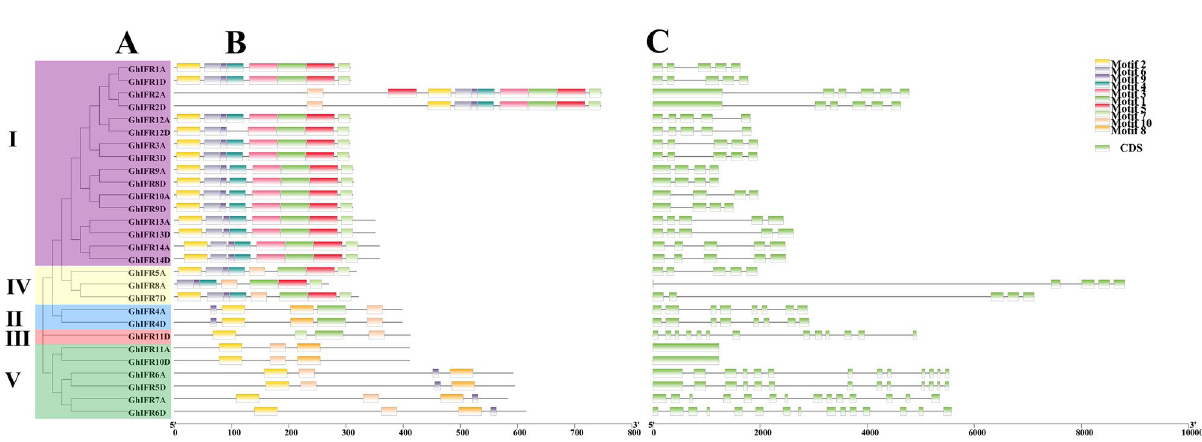
Figure 5. Phylogenetic tree, conserved motifs and gene structure analysis of GhIFR genes in G. hirsutum . ( A ) Phylogenetic tree of GhIFR genes, ( B ) Conserved motifs of GhIFR genes, ( C ) Gene structures of GhIFR genes. Green boxes indicated exons, and black lines indicated